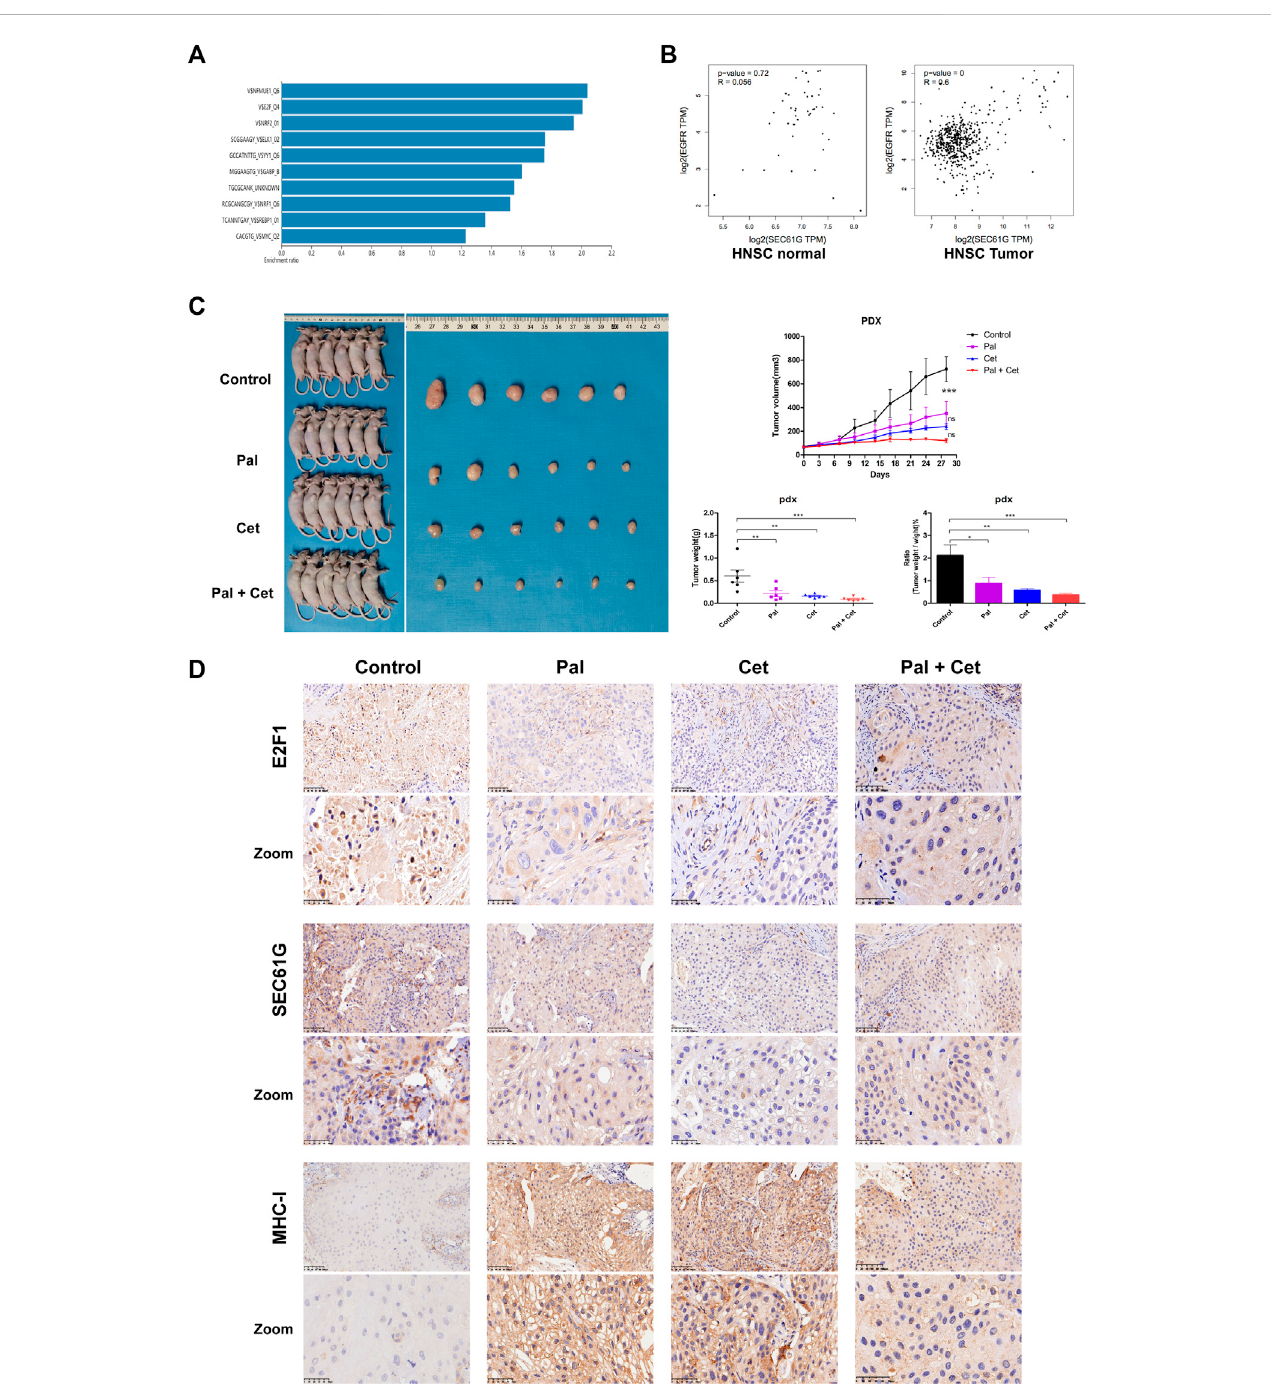
FIGURE 7 CDK4/6 inhibitor and EGFR inhibitor increase MHC-I expression by targeting E2F1/SEC61G axis. (A) “ Transcription Factor Target ” analysis for 2275 co- expressed genes related to SEC61G in HNSCC (Head and Neck Squamous Cell Carcinoma (TCGA, Firehose Legacy)) through webgestalt approach. (B) The correlationbetweentheexpressionofSEC61GandEGFRinHNSCnormalandHNSCtumorbasedonTCGA-HNSCdatabase. (C) CombinationPalbocicliband CetuximabinPatient-DerivedTumorXenograft (PDX)modelrelatedto hypopharyngealsquamous cell carcinoma. Hypopharyngeal cancerPDXmodels were treated with control, Palbociclib (100 mg/kg/day), Cetuximab (1 mg/week) or Cetuximab plus Palbociclib for 28 days (n = 6 per group). The growth curves of xenografts are shown. After 28 days, the mice were killed, and tumors were dissected, weighed and photographed. One-way ANOVA and Tukey ’ s multiple comparisons test. * p < .05, ** p < .01, *** p < .001. Pal, Palbociclib; Cet, Cetuximab; ns, not signi fi cant. (D) Immunohistochemistry staining of E2F1, SEC61G, and HLA class I ABC (MHC-I) in PDX models after treatments. Pal, Palbociclib treatment mouse; Cet, Cetuximab treatment mouse; Pal + Cet, Palbociclib plus Cetuximab treatment